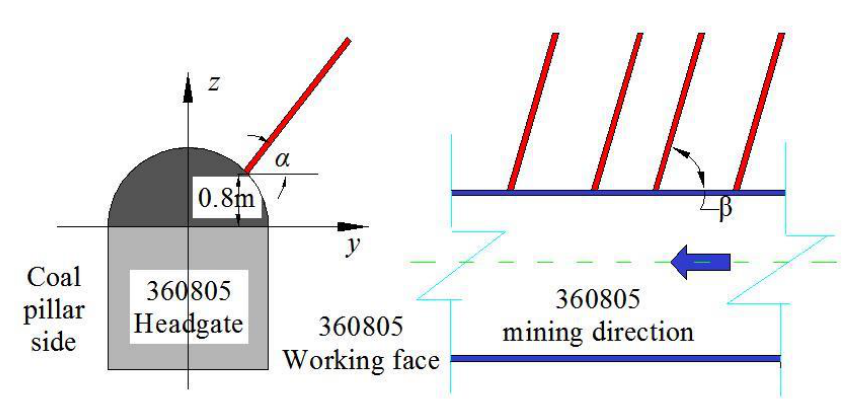
Figure 5. Borehole layout.